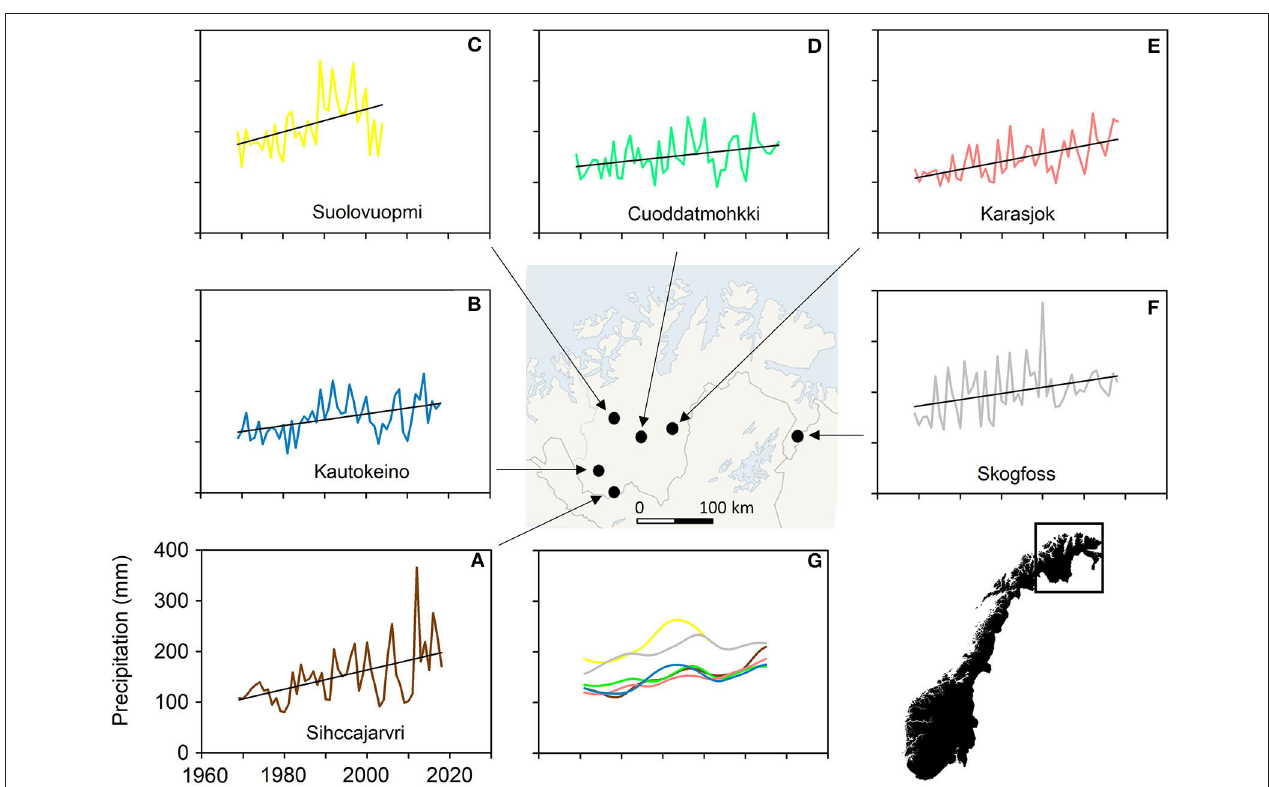
FIGURE 14 | Total precipitation in winter (October to April, O-A; mm) on the reindeer winter pasture area of Finnmarksvidda ( Figure 7 ), 1969–2018. (A–F) Raw data from six weather stations: Cuovddatmohkki, Karasjok, Kautokeino, Sihccajavri, Skogfoss and Suolovuopmi ( Figure 7 ). (G) Low-pass filtered data (window ∼ 30 years: the first and last three years in the time series from each station are excluded). Precipitation increased at all stations over the last 50 years. Linear regression coefficients (mm · year − 1 ) are Cuovddatmohkki 0.860, p = 0.1 NS ; Karasjok 1.561, p < 0.001; Kautokeino 1.157, p < 0.001; Sihccajavri 1.190, p < 0.001; Skogfoss